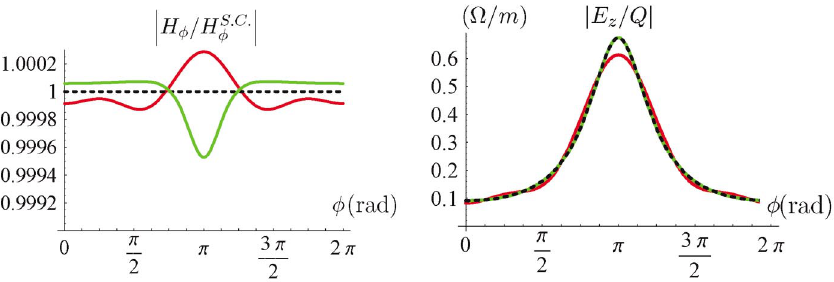
FIG. 6. (Color) Azimuthal magnetic field and longitudinal electric field on the boundary at 1 GHz. The dashed black line is the result of the perturbative approach. The red line is an analytical solution including only the first three (cid:19) harmonics for (cid:1) 0 : 999 999 and the green one is the complete solution. ( b (cid:1) 2 cm , n (cid:1) 1